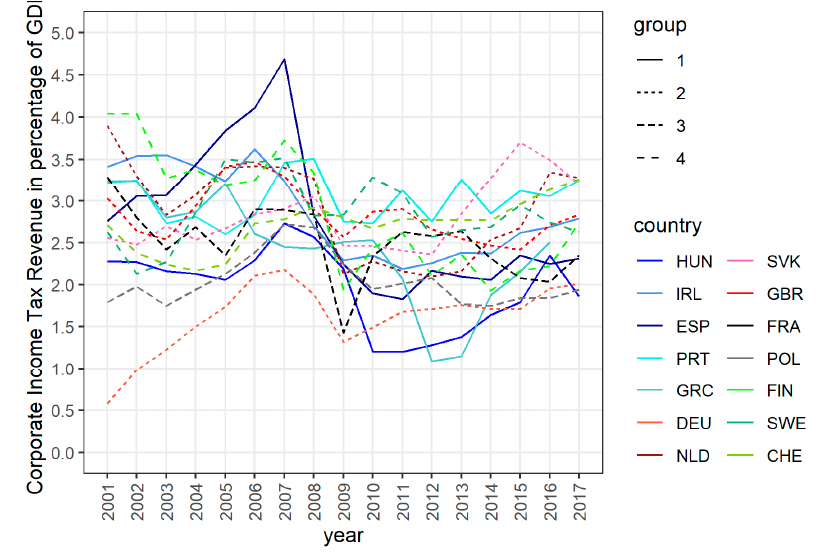
Figure 7. The development of the corporate income tax revenues in analyzed countries.